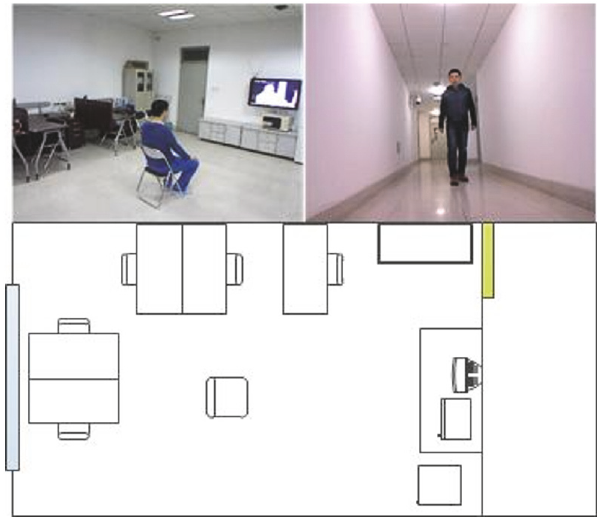
Figure 4: Illustration of intelligent space